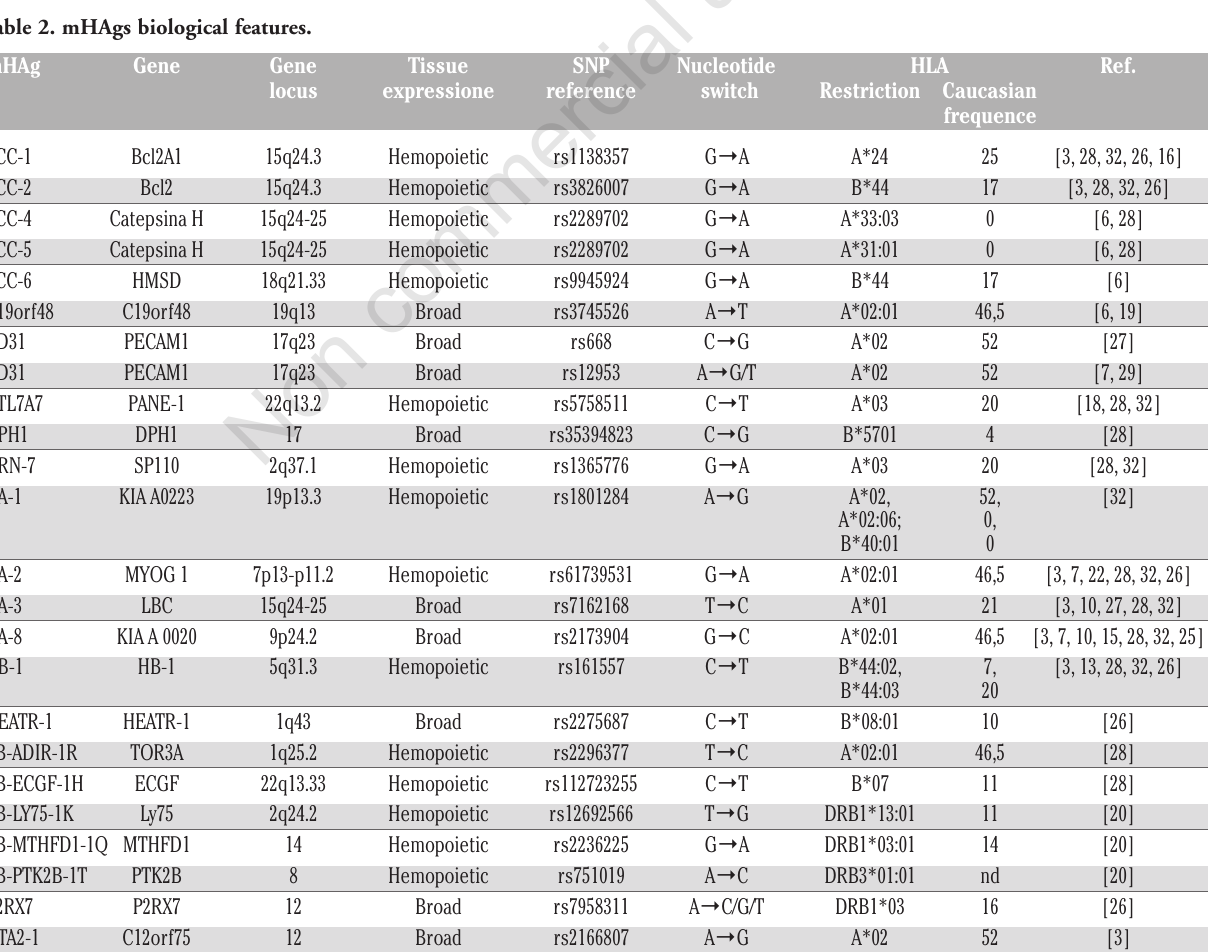
Table 2. mHAgs biological